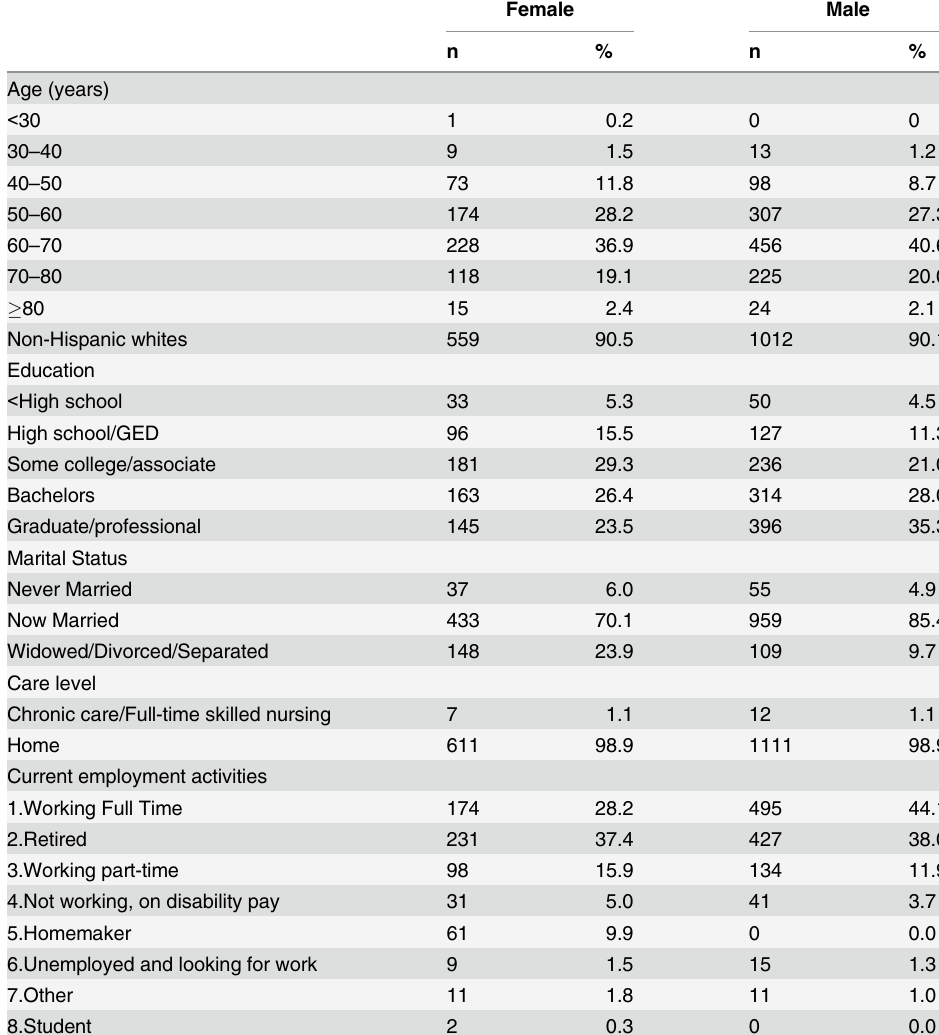
Table 1. Demographic Characteristics (N =